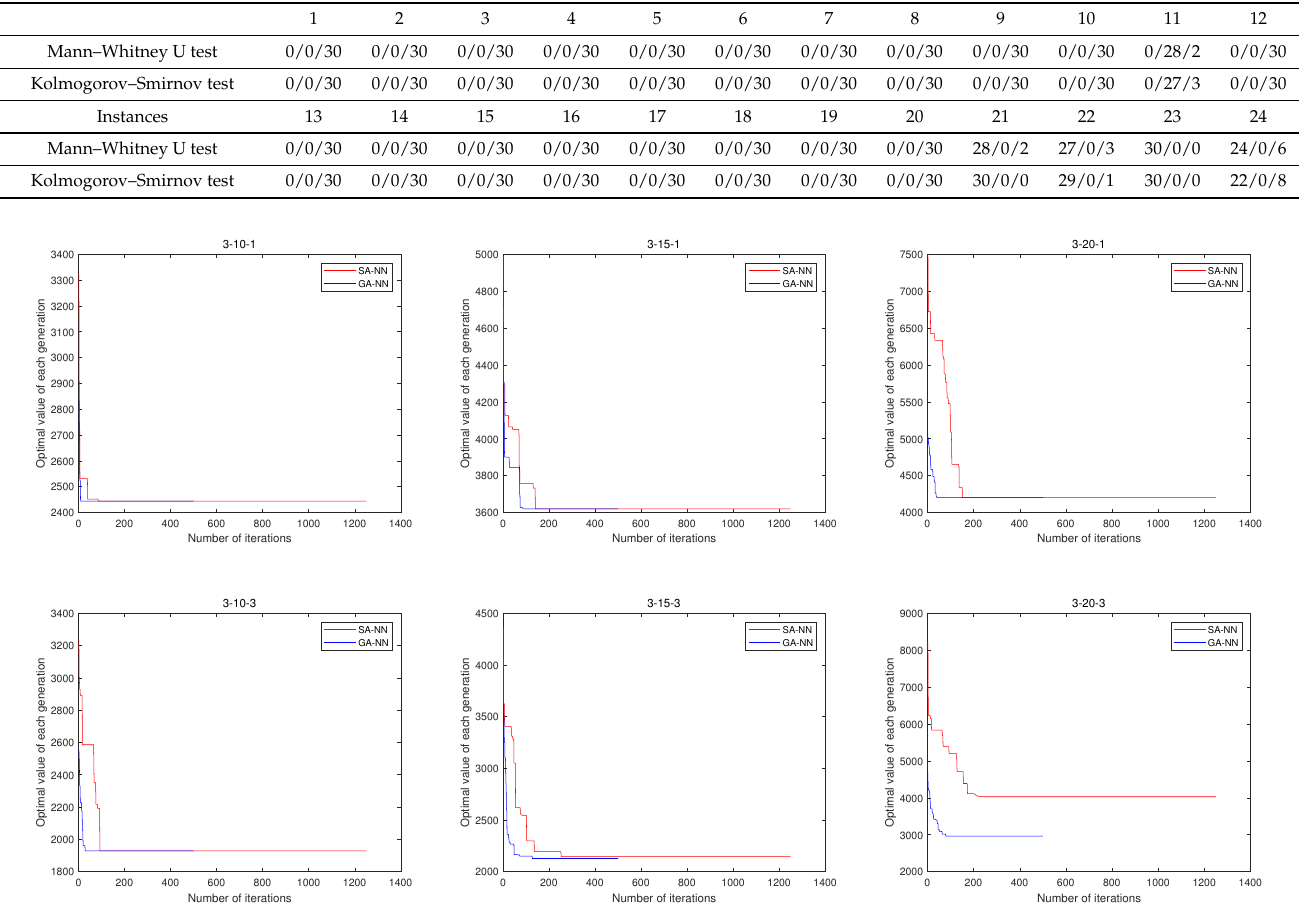
Figure 6. Objective value evolution curve for Instance